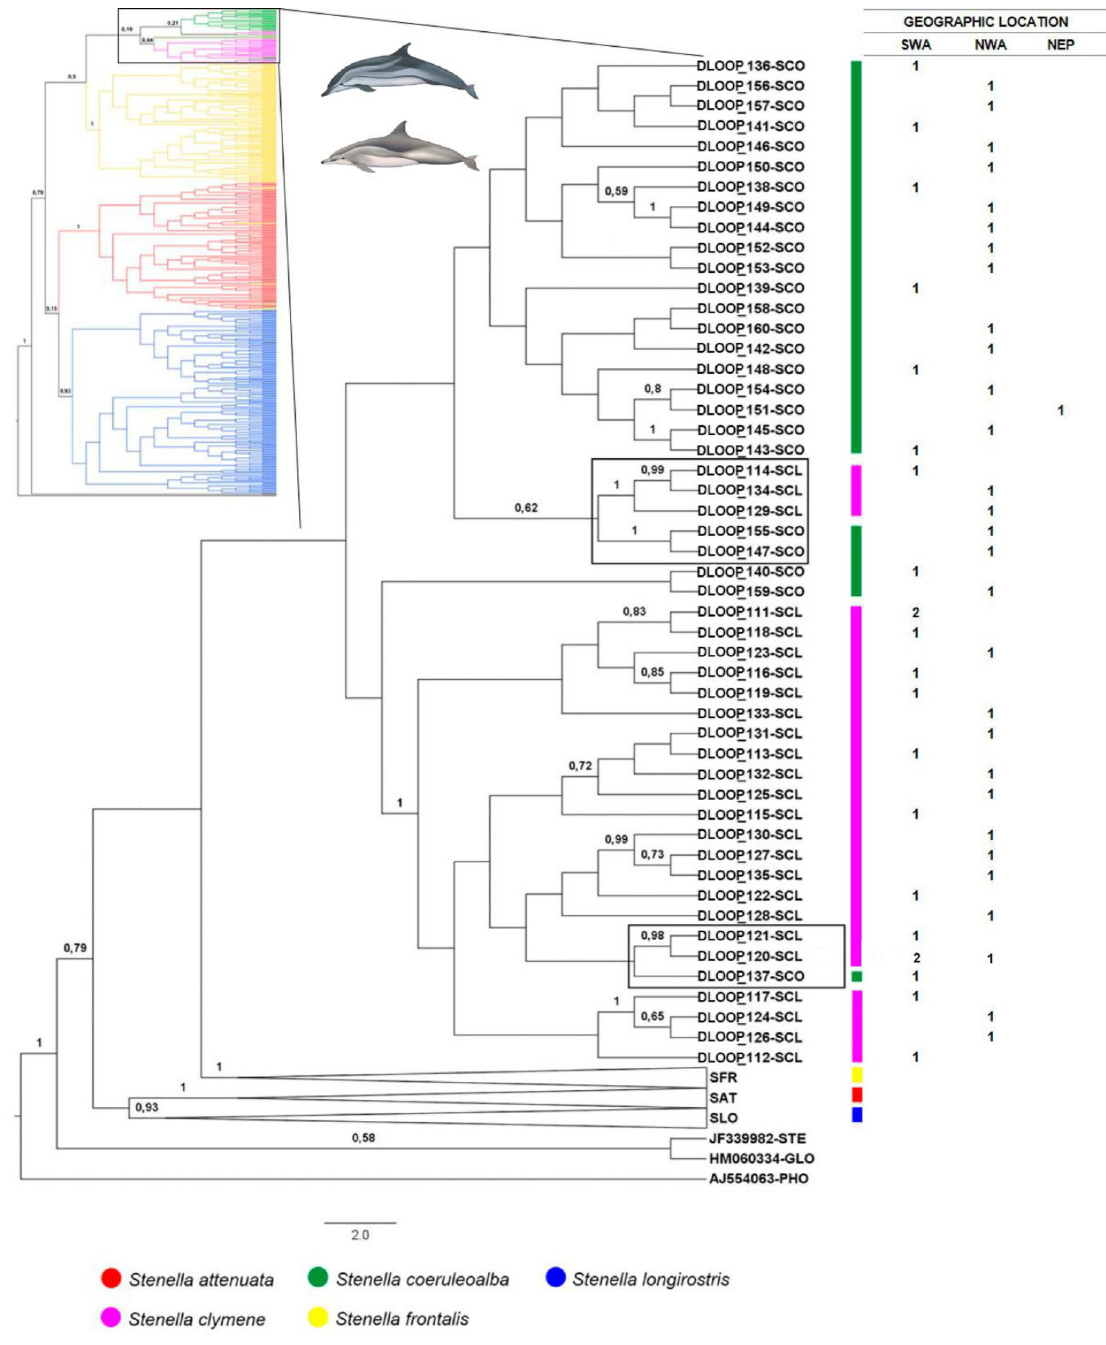
Fig 5. Bayesian cladogram generated by Beast from the Dloop sequences (331bp) highlighting the clade of S . clymene and S . coeruleoalba for ocean basin comparisons. Posterior probability values greater than 0.5 are presented above nodes. Black boxes indicate misplaced haplotypes. Asterisk indicate haplotypes presents in different species. Table at right displays the ocean basin location of each haplotype and the number of specimens: SWA (Southwest Atlantic Ocean), NWA (Northwest Atlantic Ocean), NEP (Northeast Pacific Ocean). The numbers in the columns represent the number of specimens for each haplotype. Dolphins images have been extracted from the website http://cis.whoi.edu/science/B/whalesounds/index.cf.